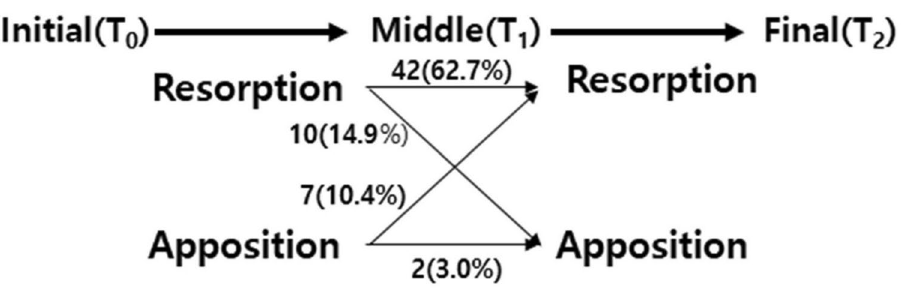
Figure 2. Changes in resorption and apposition of the superior part of condyle over time. T 0 , initial timepoint; T 1 , middle timepoint; T 2 , final